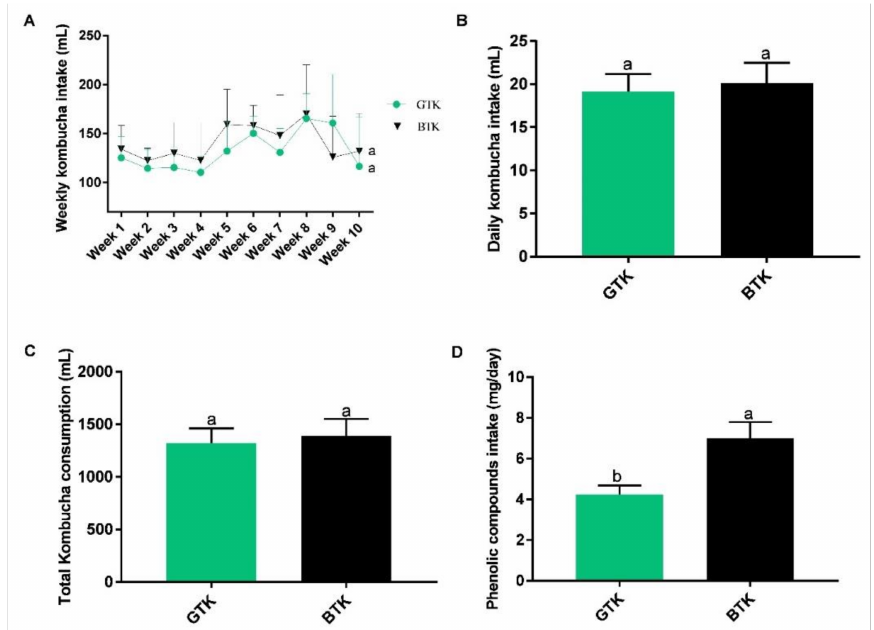
Figure 2. Weekly kombucha intake ( A ), daily kombucha intake ( B ), total kombucha consumption ( C ), and phenolic compounds intake ( D ) by the animals during the treatment. Data were expressed as mean ± SD. Different letters indicate a significant difference ( p < 0.05) between groups according to t-test. GTK: HFHF diet + green tea kombucha diluted in water (30% v / v ); BTK: HFHF diet + black tea kombucha diluted in water (30% v / v